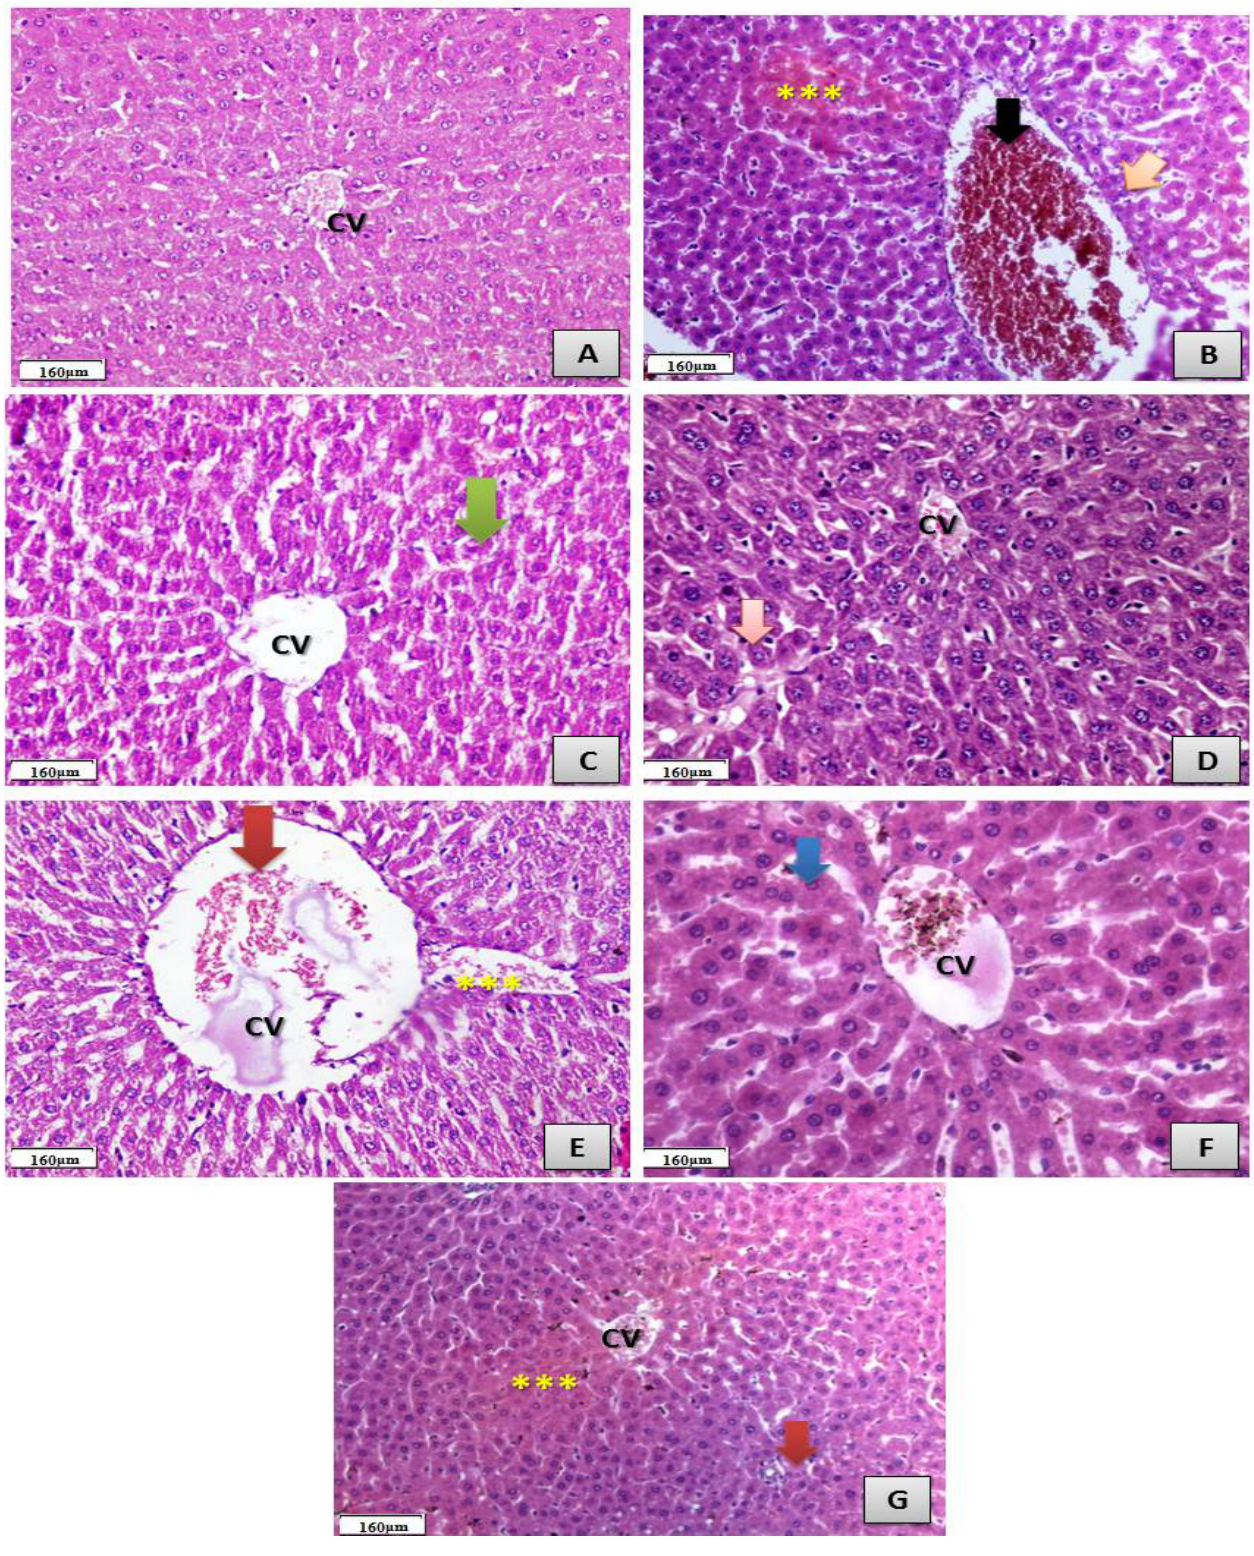
Figure 8. Photomicrographs showing histological sections of the hepatic tissues. ( A ) Control group showing normal hepatic structure and normal central vein (CV) (H&EX400). ( B ) CFX-treated group showing severe toxicity in the form of the hypertrophy of hepatocytes (orange arrow) with the appearance of binucleated hepatocytes and increased eosinophilia, granular cytoplasm and vesic- ular nuclei (***); the central vein is dilated and filled with hemorrhage and necrotic tissue (black arrow), with focal necrosis in some hepatocytes with increased eosinophilia and nuclear disap-